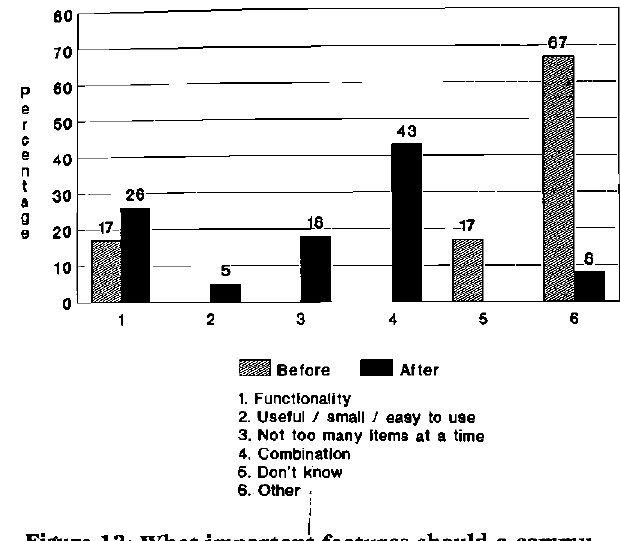
Figure 12: What important features should a commu- nication hoard incorporate?